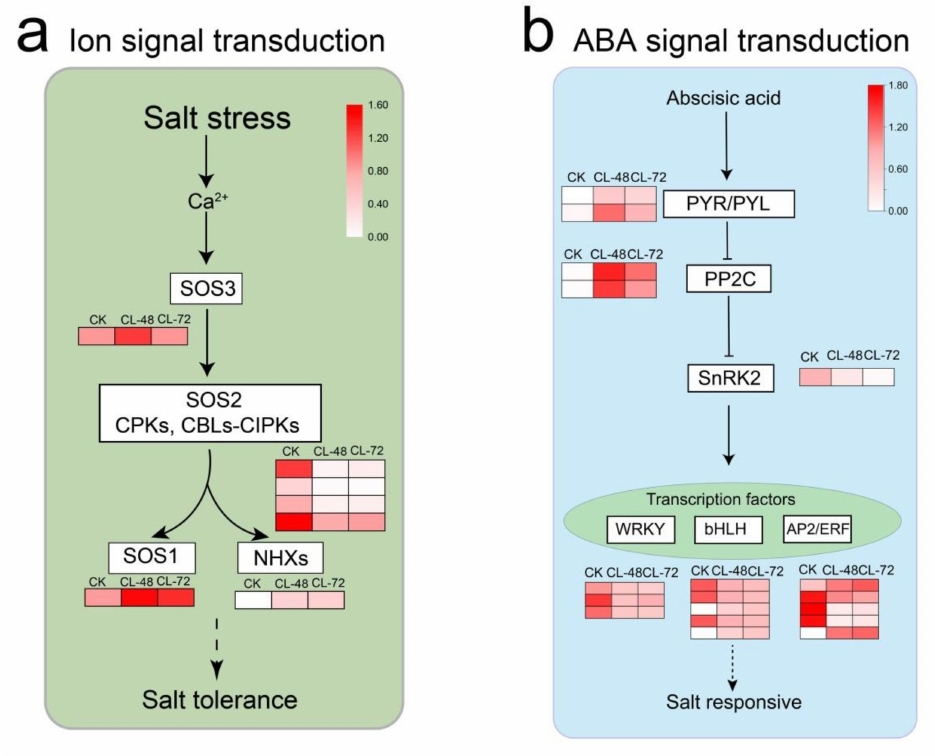
Figure 6. Genes involved in the response to salt stress in H. hamabo transcriptomes. Relative expression profiles were showed in white-red scale. ABA, abscisic acid; PYR/PYLs, pyrabactin resistance 1-like protein; PP2C, type 2C protein phosphatases; SnRKs, Snf1 (sucrose